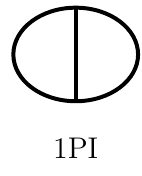
Figure 2 . 1PI versus 1PR two-loop